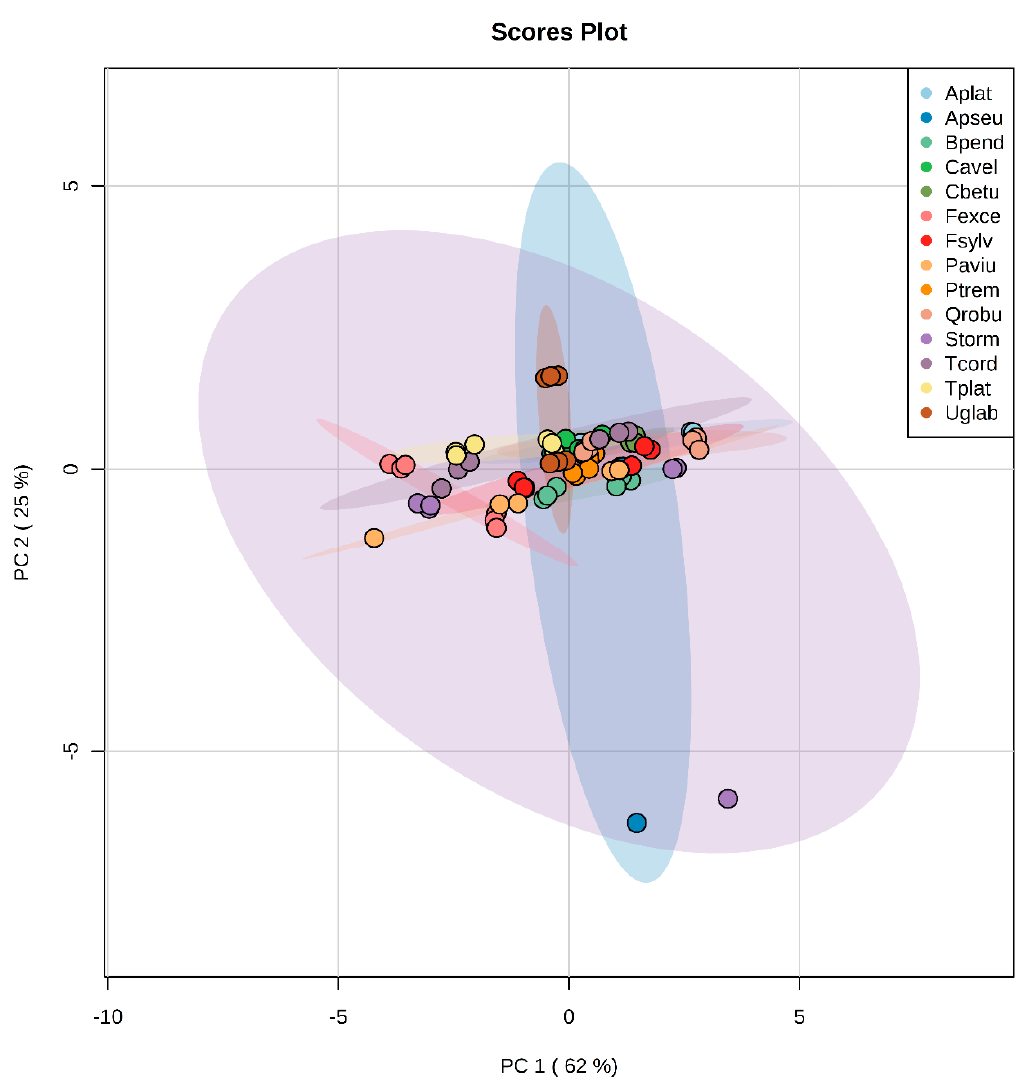
Figure 5. Two-dimensional score plot of principal component analysis computed with concentrations of total N, soluble amino acids, proteins, and phenolics in leaf litter (after senescence) for the combined years. Subgroups are shown in different colours. The explained variances (in percentage) are reported in x - and y -axes in the plot.